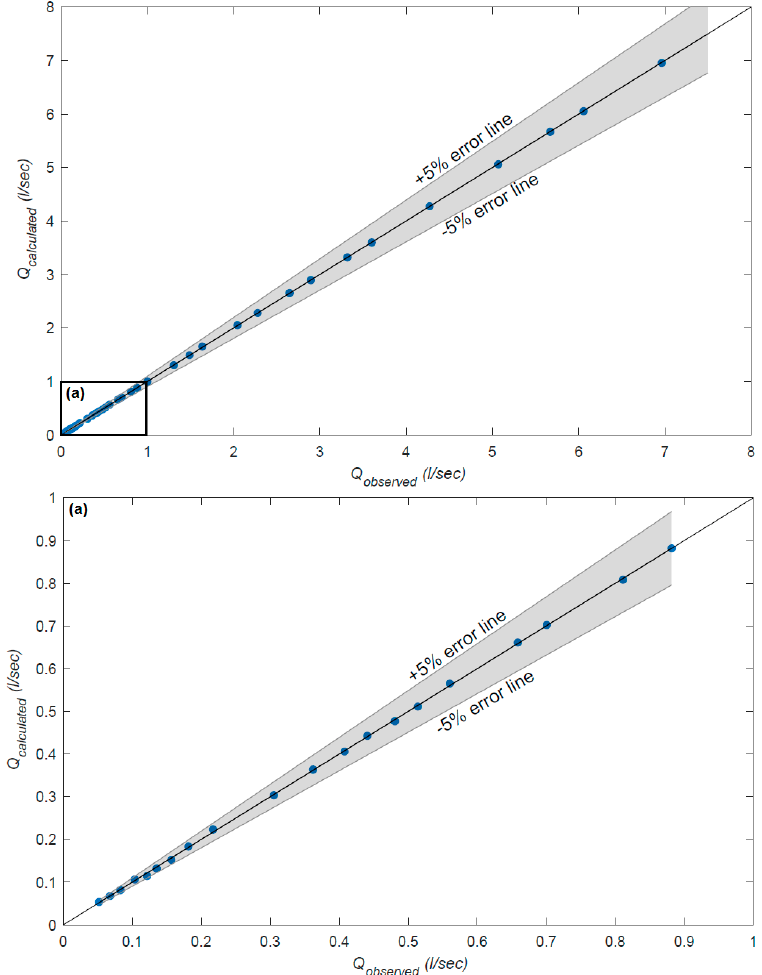
Figure 8. Calculated discharge ( Q calculated ) against observed ones ( Q observed ) and a close-up look into low values ( a